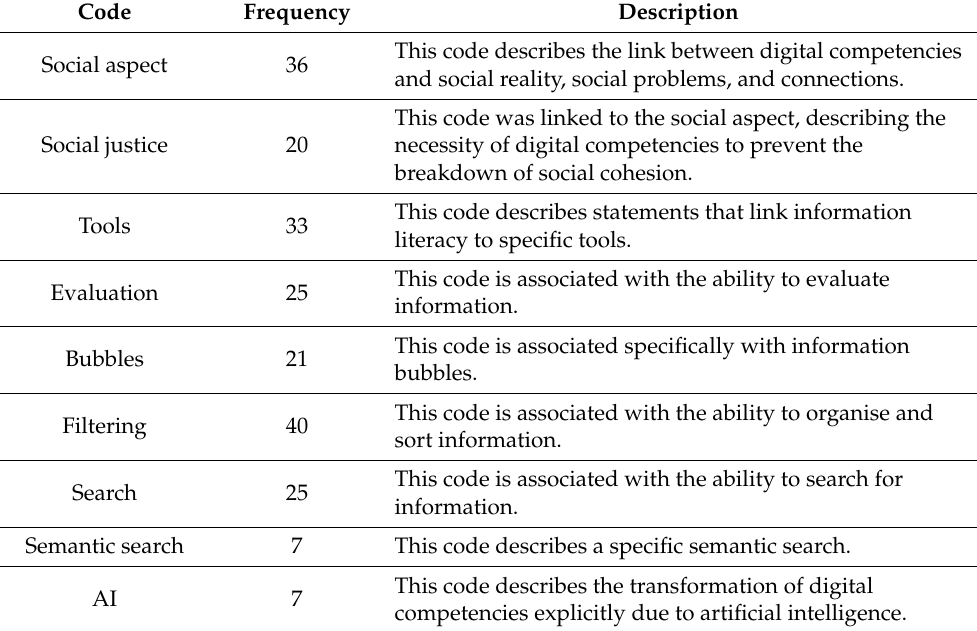
Table 2. Codes used in the